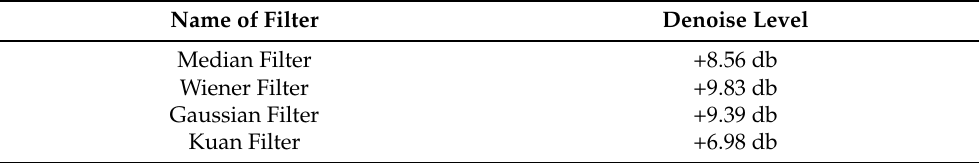
Table 3. Denoise